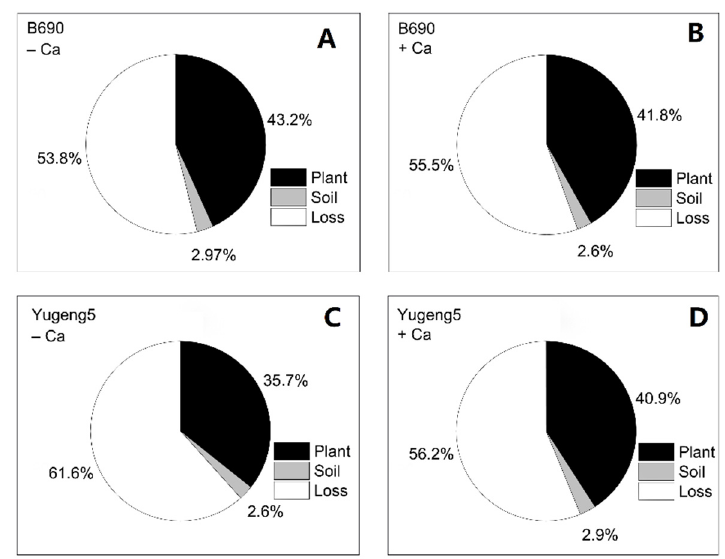
Figure 7. Distribution of 15 N-labeled fertilizer nitrogen (N) in plant-soil system after harvesting of two rice cultivars ‘B690 ′ and ‘Yugeng5 ′ . ( A ), B690, − Ca; ( B ), B690, +Ca; ( C ), Yugeng5, − Ca; ( D ), Yugeng5, +Ca. Two rice cultivars were grown in pots in a greenhouse without ( − N) or with (+N) N fertilizer, in the absence ( − Ca) or presence (+Ca) of lime, till maturity.